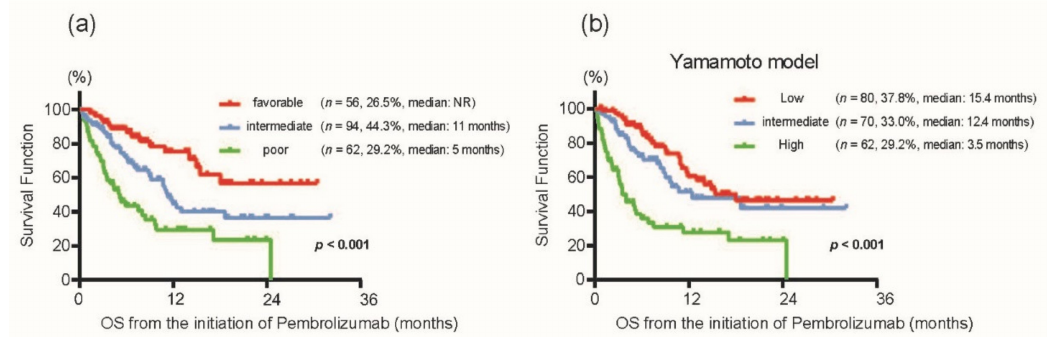
Figure 4. ( a ) Kaplan–Meier curves for overall survival from the initiation of pembrolizumab treatment according to the risk model in the present study. ( b ) Kaplan–Meier curves for overall survival from the initiation of pembrolizumab treatment according to the risk model from Yamamoto et al. [10] using our